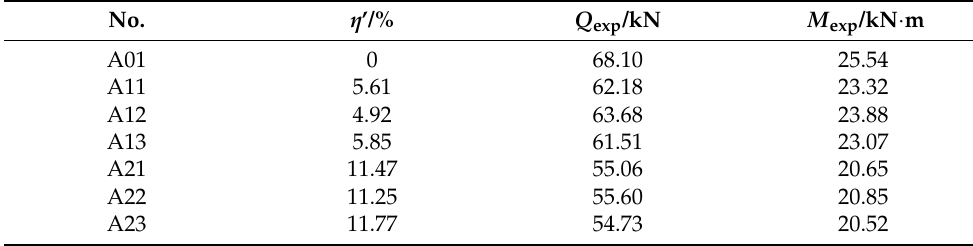
Table 4. Experimental